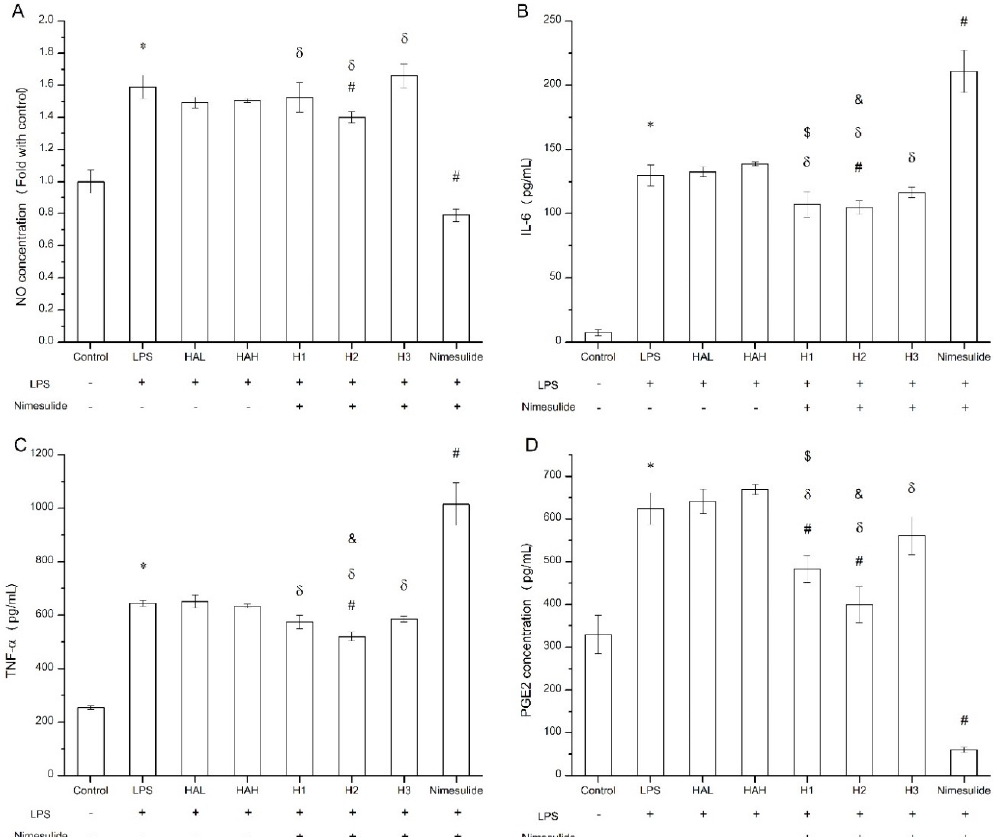
Figure 8. Anti-inflammatory evaluation of free HA, nimesulide, and HA-nimesulide conjugates in LPS-stimulated Raw 264.7 cells displayed as ( A ) the ratio of nitric oxide concentration compared with control group, and ( B ) IL-6, ( C ) tumor necrosis factor alpha, and ( D ) PGE2 concentrations in the culture medium. * p < 0.05 versus the control group. # p < 0.05 versus the LPS group. δ p < 0.05 versus the nimesulide group. $ p < 0.05 versus the HAL group. & p < 0.05 versus the HAH group.